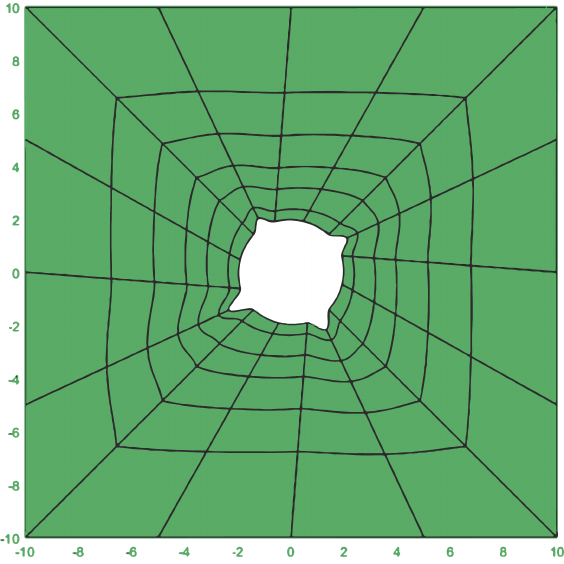
Figure 25. Case 5: physical domain and